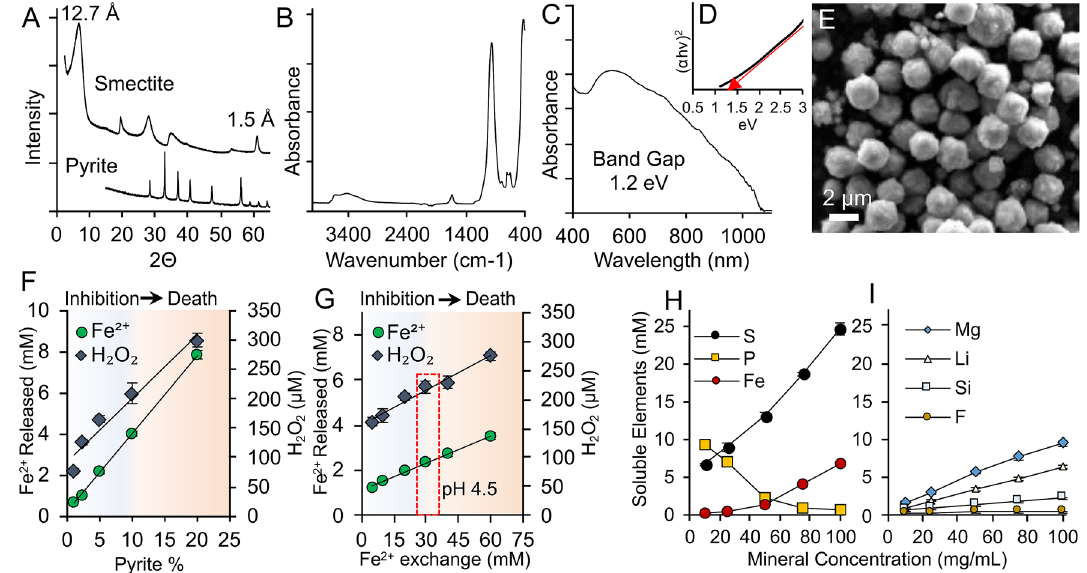
Figure 1. Synthesis and tuning of antibacterial mineral activity. (A) XRD patterns of synthetic smectite and pyrite showing single mineral phases. (B) FTIR spectrum of synthetic smectite. (C,D) Band-gap measurements of synthetic pyrite. (E) SEM images of synthetic pyrite particles, showing micro-spheres with a 1–2 µm size range. (F,G) Antibacterial activity of antibacterial mineral mixtures (50 mg/mL) tested against E. coli in TSB media for 4 h while (F) varying pyrite concentration (1–20 wt.%) with a fixed concentration of Fe 2+